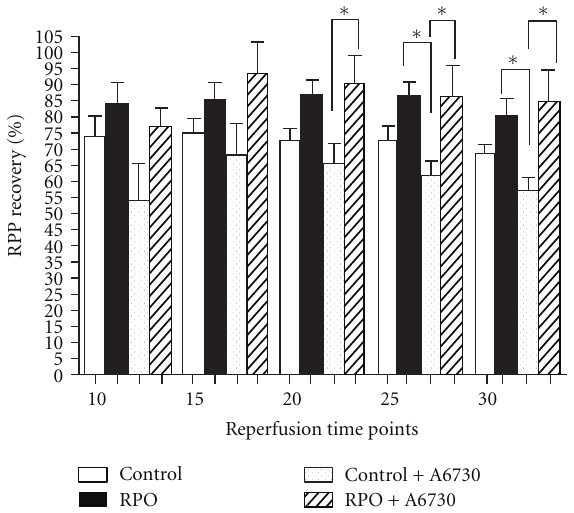
Figure 5: E ff ect of RPO and Akt-1-1/2 inhibitor (A6730) on RPP recovery (%). Results expressed as means ± SEM ( ∗ P < 0 . 05 for indicated groups). Controls ( n = 7), RPO ( n = 7), control + A6730 ( n = 5), and RPO + A6730 ( n =